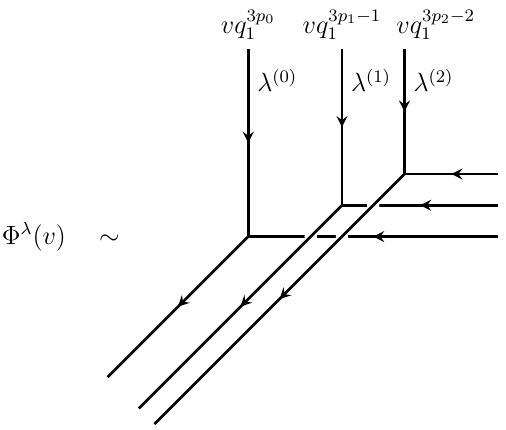
Figure 4 . The intertwiner of Fock representations of U q =1 ; d ( bb gl ) drawn in terms of the intertwiners 3 of Fock representations of U q =1 ; d ( bb gl ). The Young diagrams (cid:21) ( d ) on the vertical legs are the quotients 1 of the Young diagram (cid:21) , and the spectral parameters of the vertical legs depend on the shifts p c obtained from the quotient construction. More details on the quotients of Young diagrams are collected in appendix